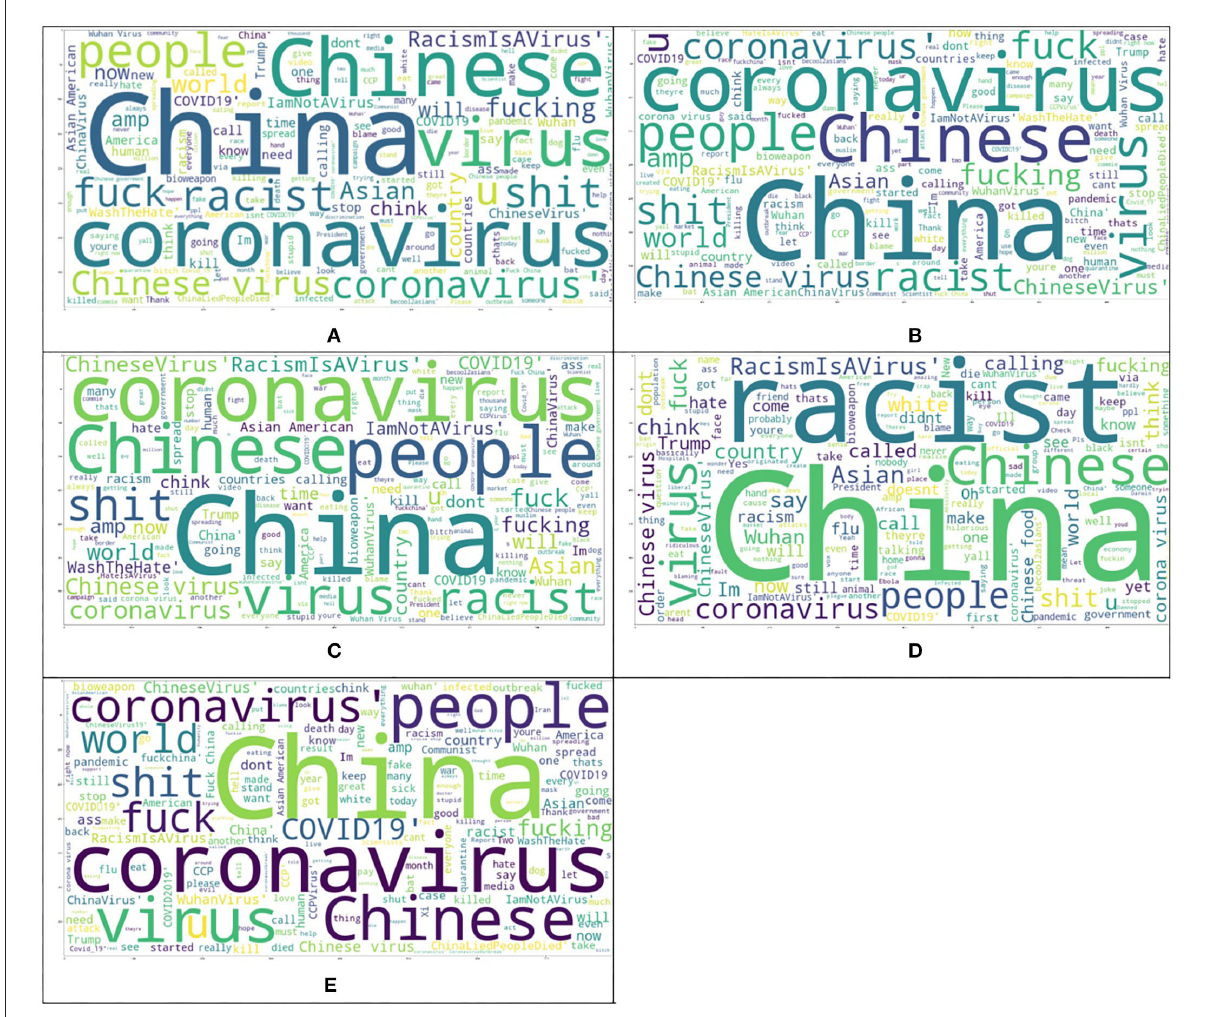
FIGURE3 Comparing the wordcloud of different datasets. (A) Baseline dataset, (B) Our dataset, (C) Our improved dataset, (D) Ambiguous dataset, and (E) Dataset with full agreement.